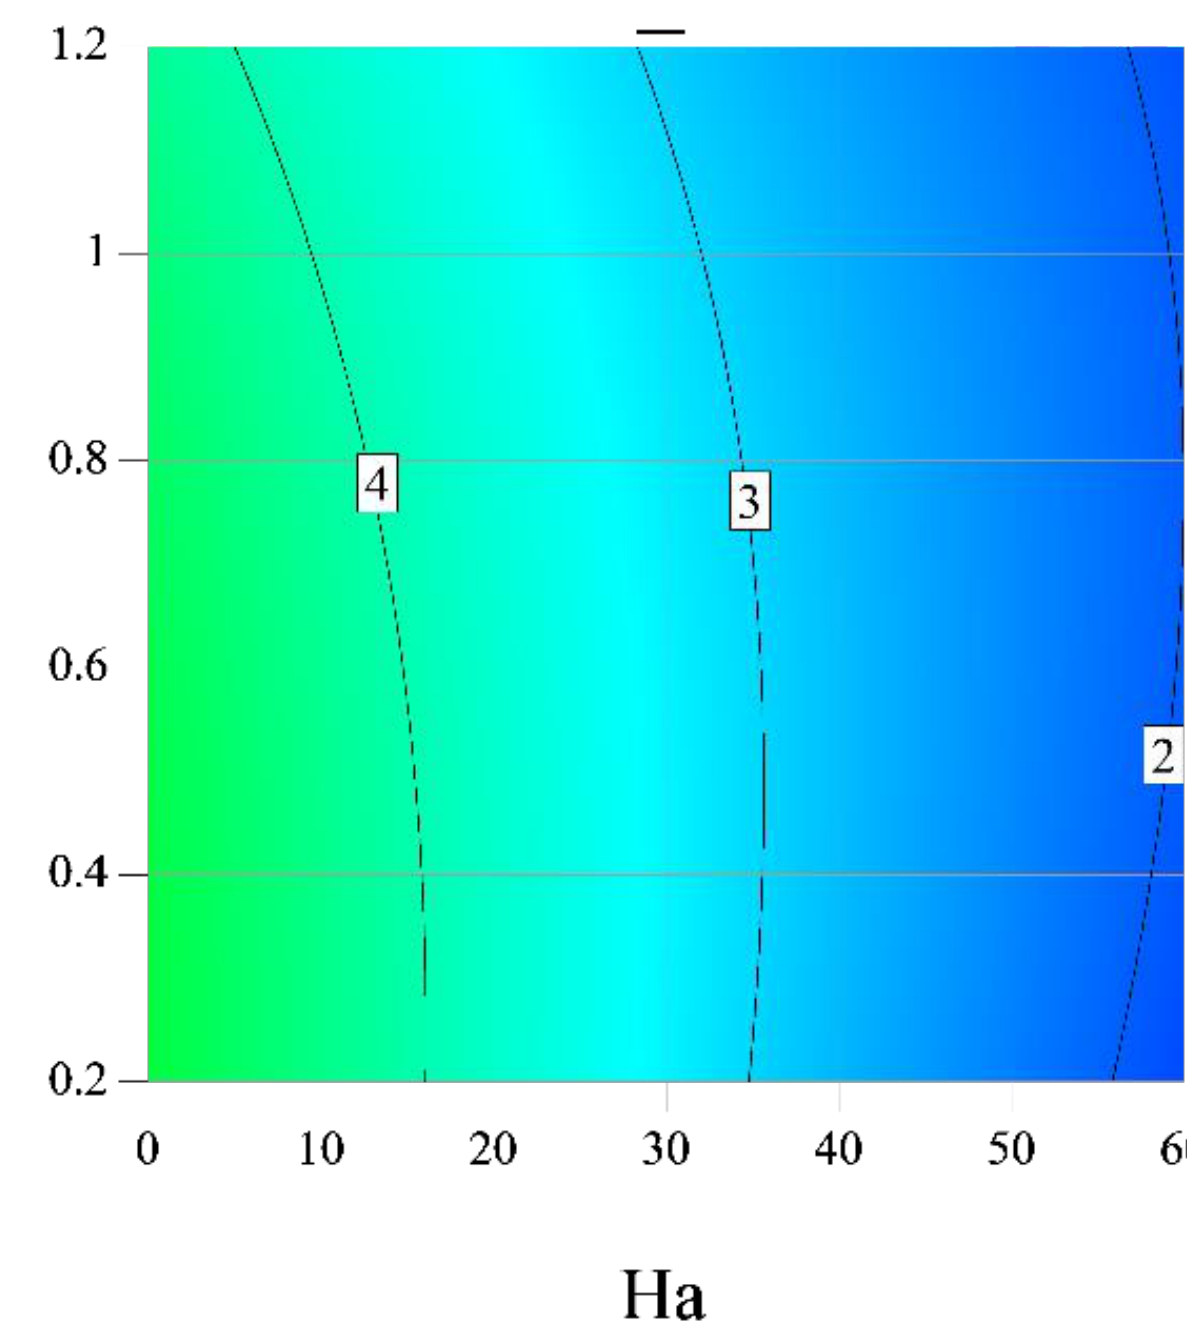
the EGN by 6.2% compared to the base